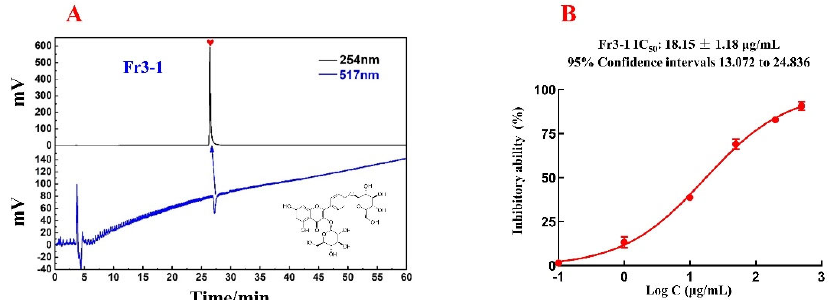
Figure 5A, the purity of Fr3 − 1 is over 95%.